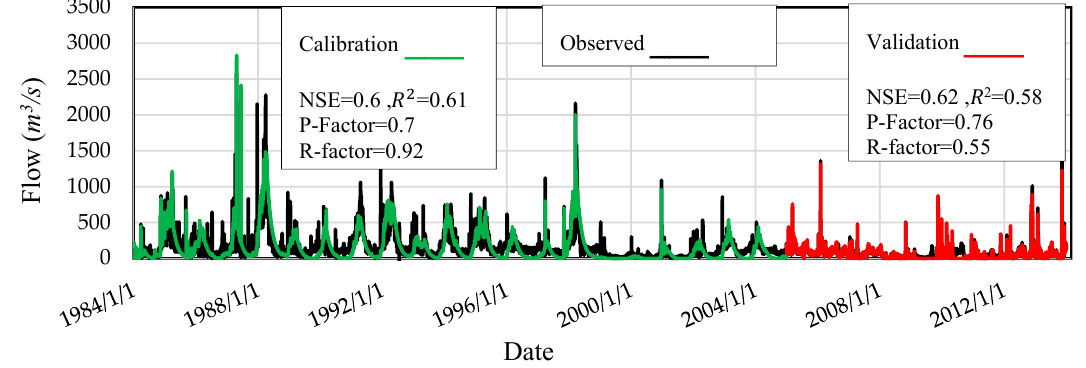
Figure 7. Calibrated and validated streamflow of the Hemrin Watershed.